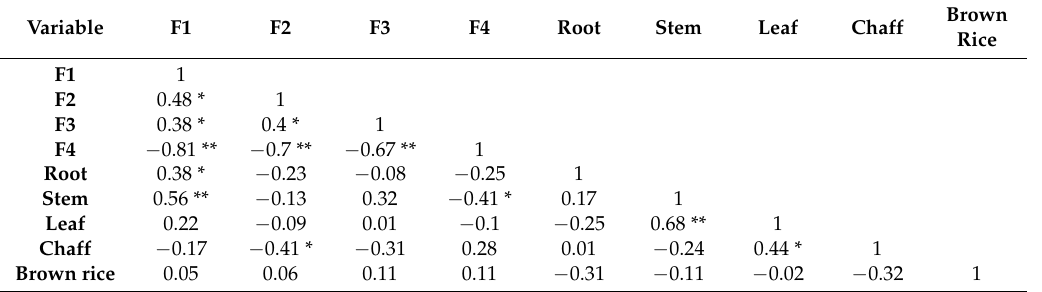
Table 4. Correlation matrix among various soil Cu forms and Cu concentrations in root, stem, leaf, spike, and grain of rice plant ( n = 27).